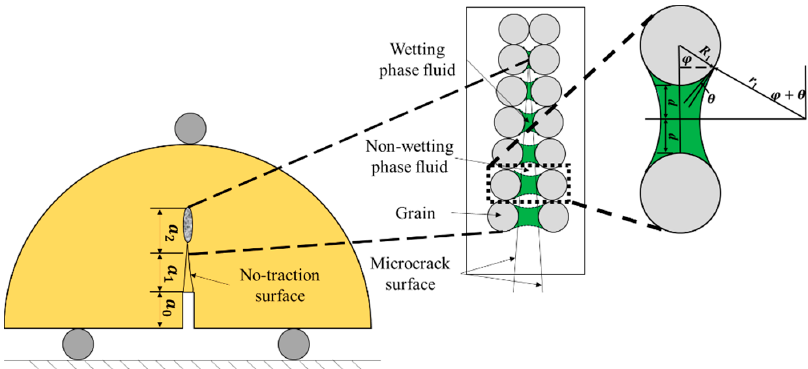
Figure 1. Schematic diagram of pore fluids at the fracture tip.